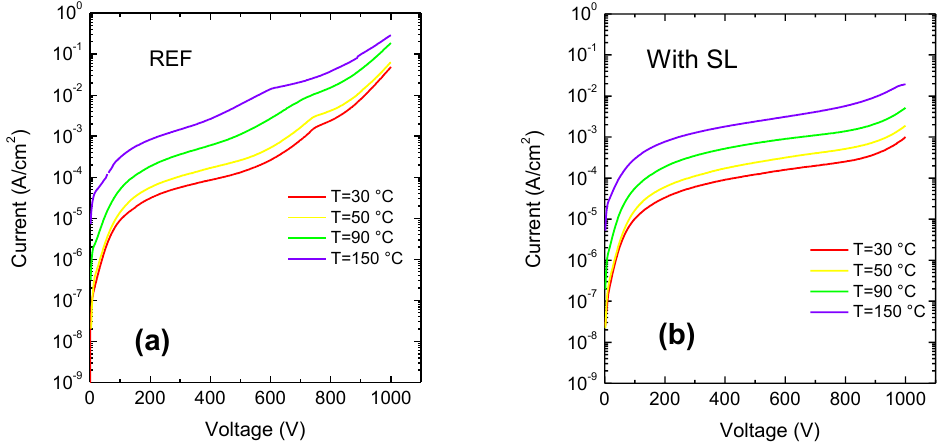
Figure 3. Vertical leakage current from room temperature up to T = 150 °C with ( a ) reference sample, ( b ) sample with SL.